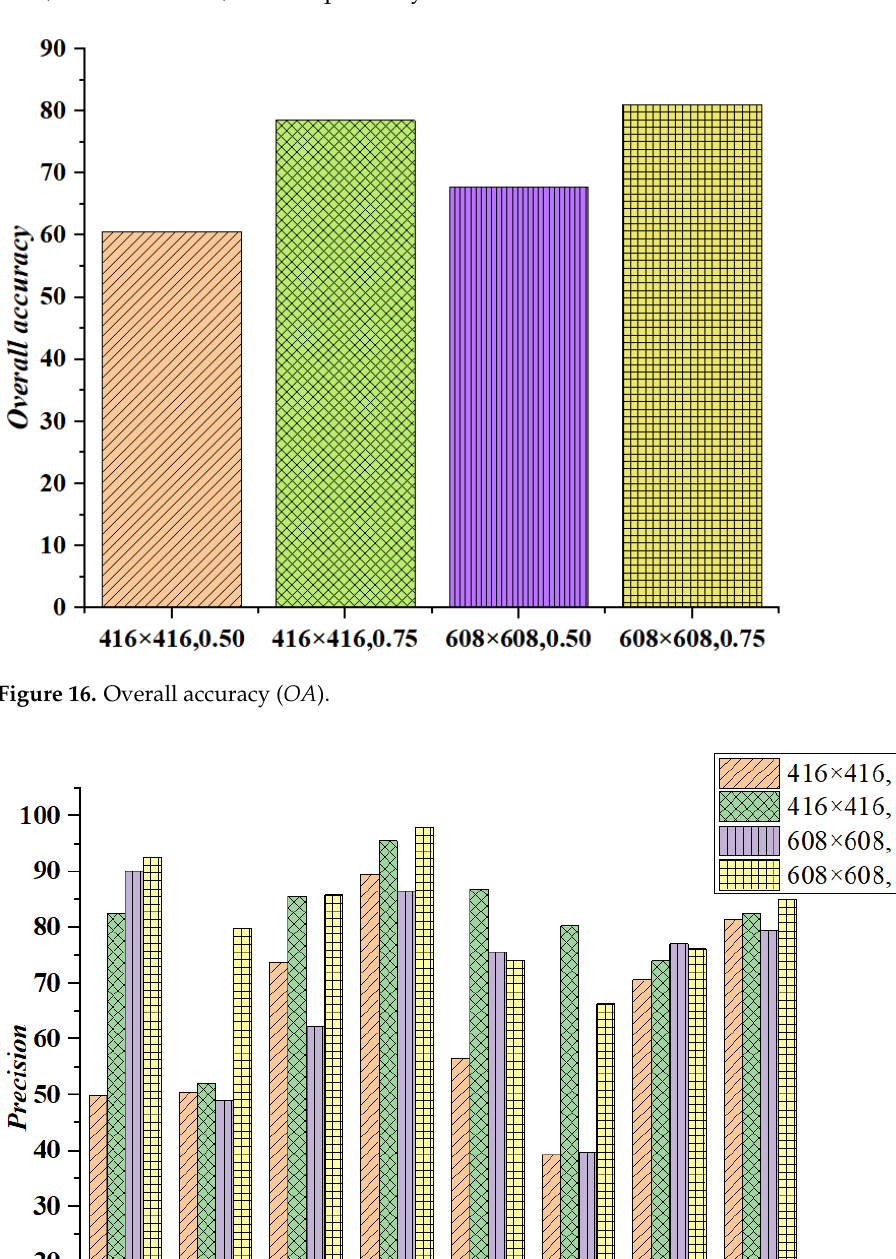
( d ) Figure 15. Confusion matrix obtained with network size and IoU _threshold ( a ) 416 × 416, 0.50 ( b ) 416 × 416, 0.75 ( c ) 608 × 608, 0.50 ( d ) 608 × 608, 0.75.